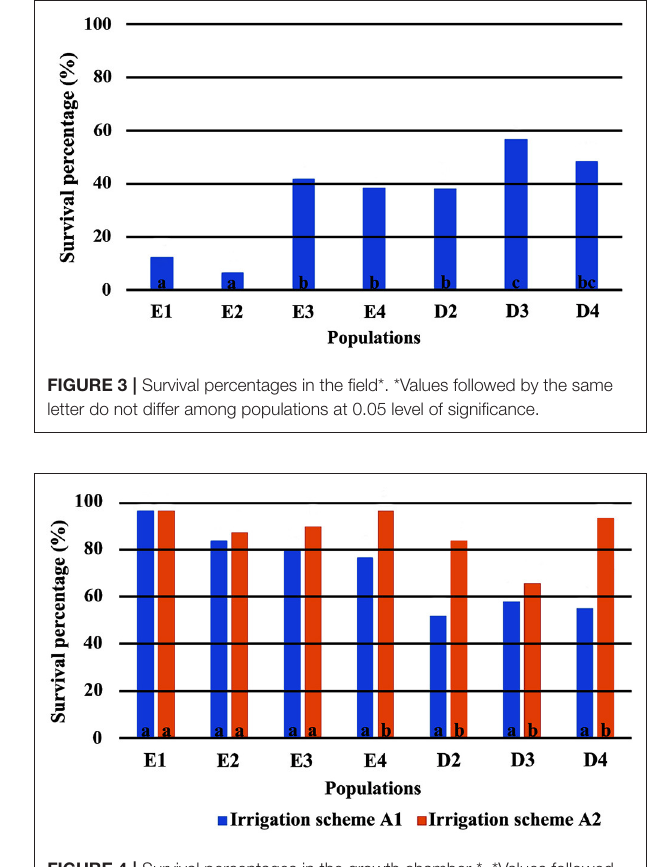
FIGURE 4 | Survival percentages in the growth chamber *. *Values followed by the same letter do not differ between irrigation schemes for each population